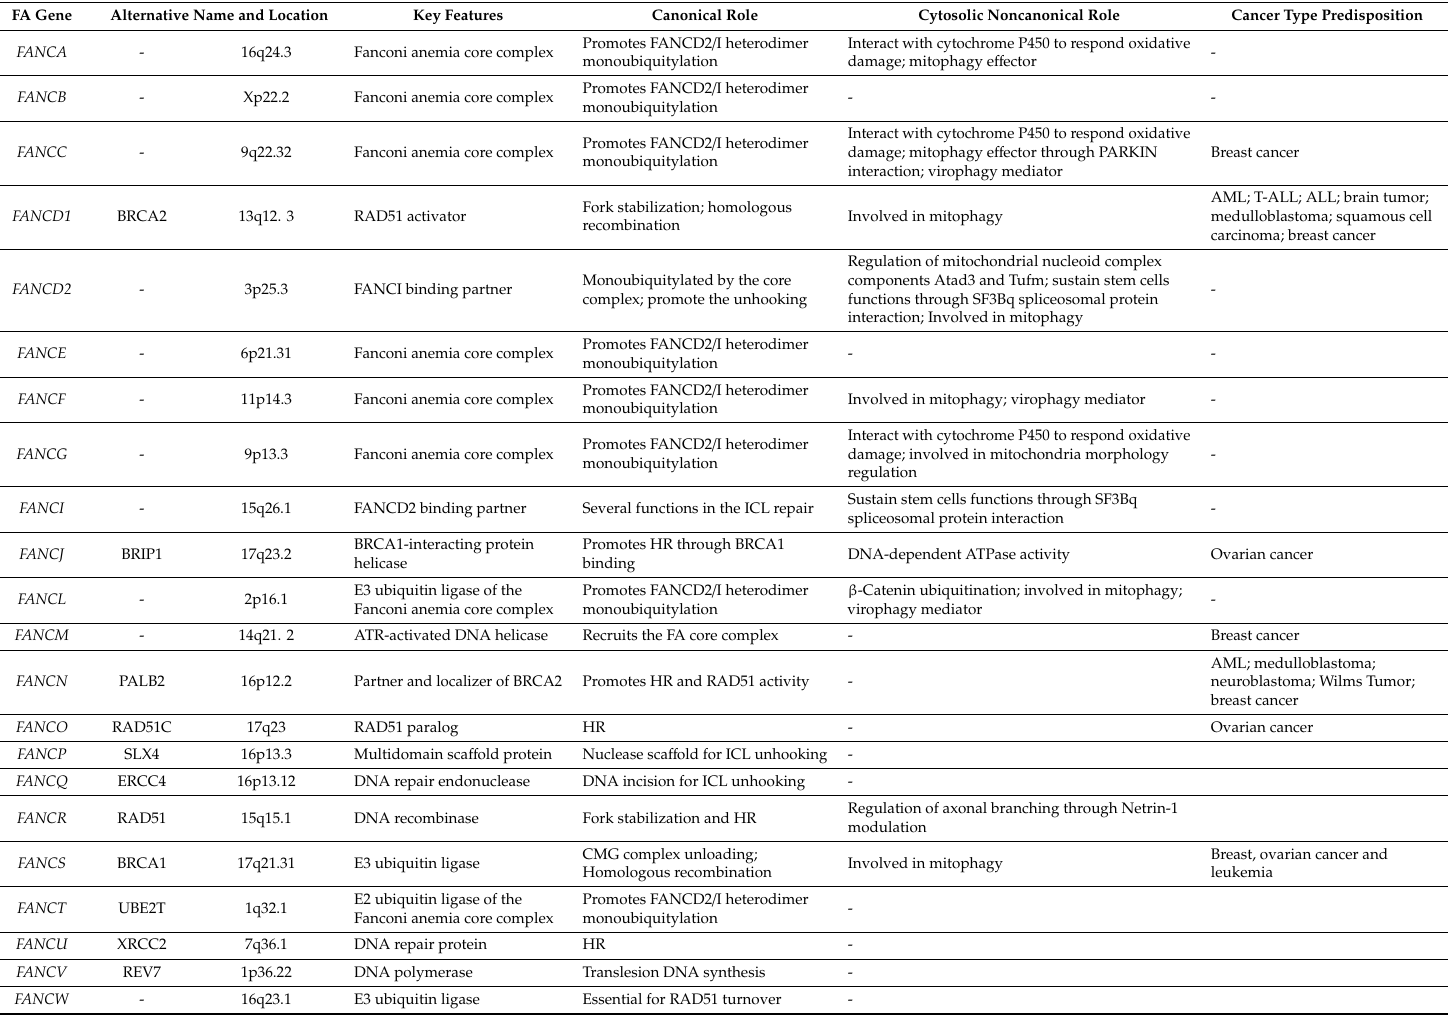
Table 1. Canonical and noncanonical roles of FA